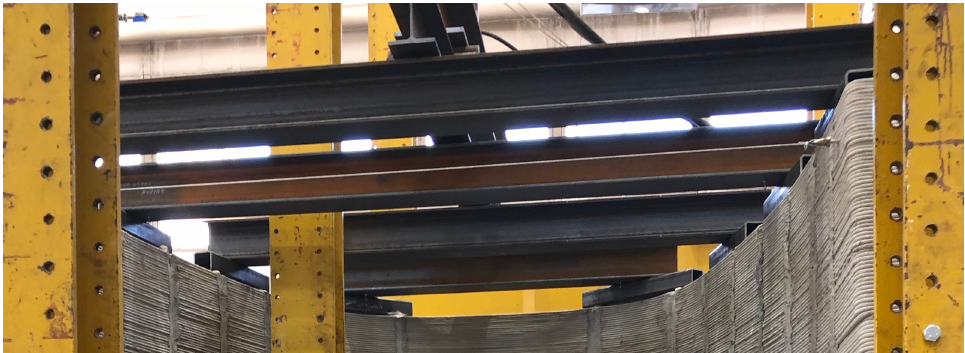
Figure 8. Load distribution system.